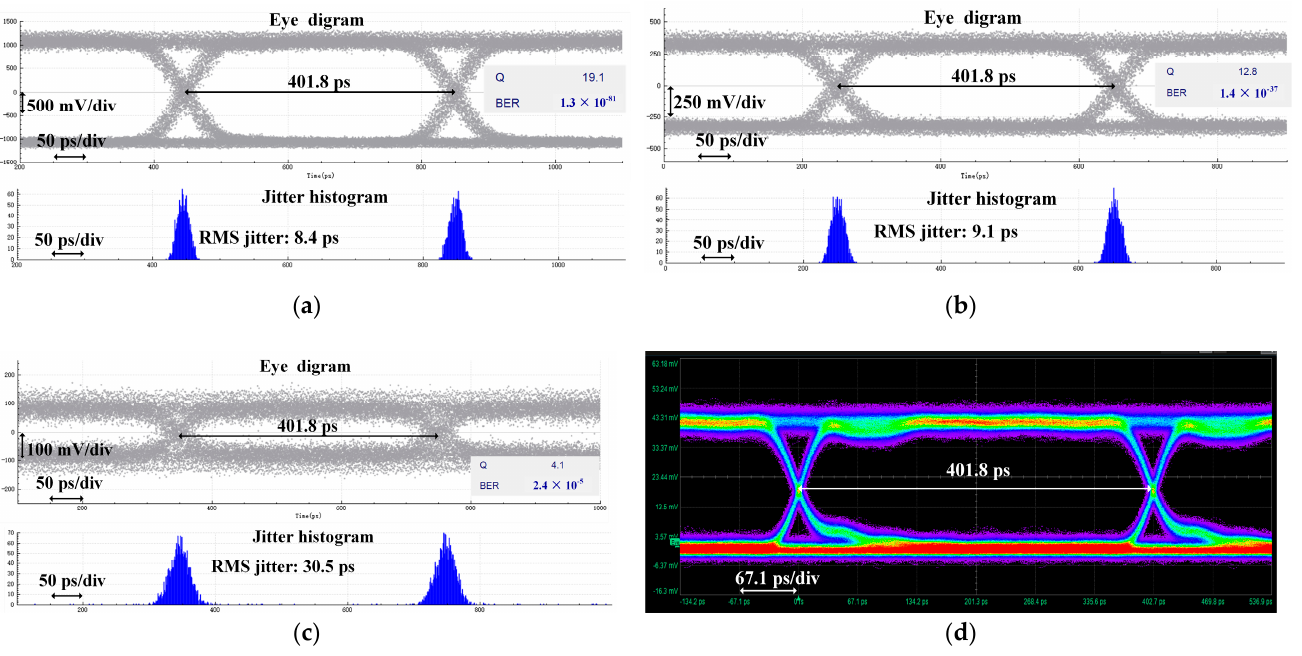
Figure 6. The measured eye diagrams and time jitter histograms when the optical signals under test from an optical transmitter (HUAWEI-2.5 GHz–40 km) have different powers of ( a ) − 8 dBm, ( b ) − 14 dBm, and (c) − 20 dBm. ( d ) The measured eye diagram by the commercial real-time oscilloscope.